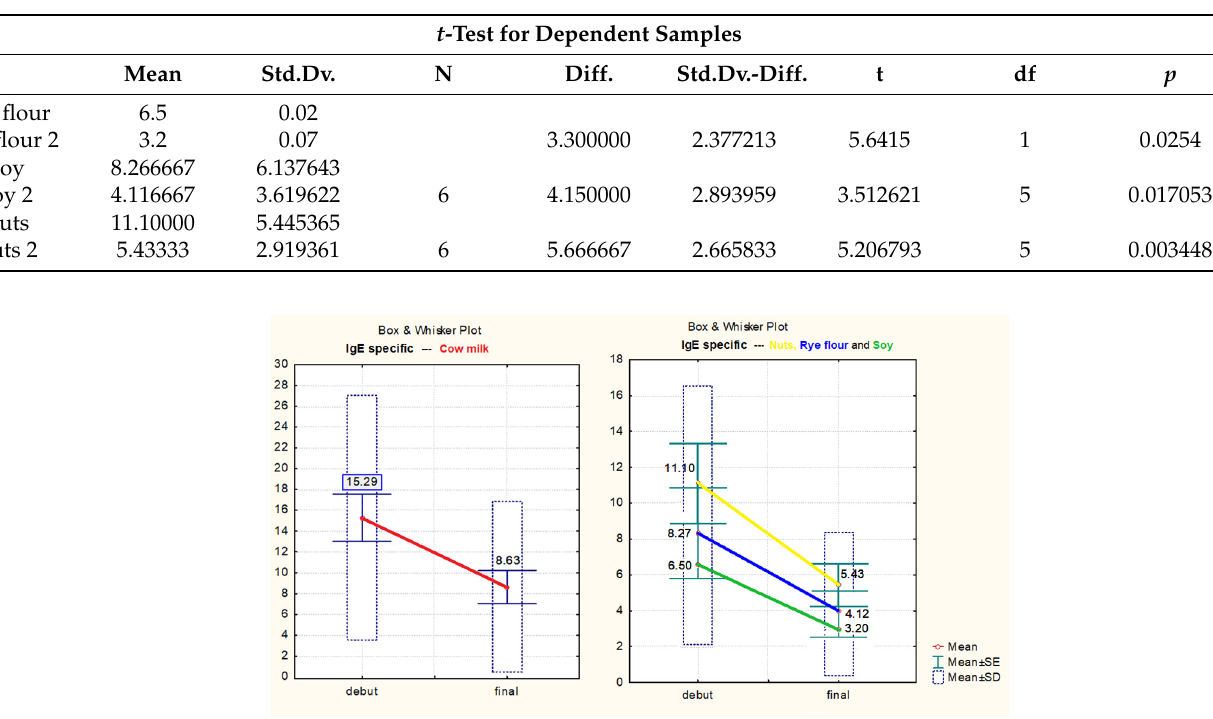
Figure 7. Specific IgE values in dynamics of cow milk, nuts, rye flour, and soy. Skin prick tests were performed in 53 patients and of these, 52.63% were positive. Correlation of skin prick tests with the IgE levels showed a good correlation between results. Thus, significantly higher values were observed in the case of positive tests (H Kruskal- Wallis = 6.88, p = 0.038, 95% CI) (Table 8, Figure 8).